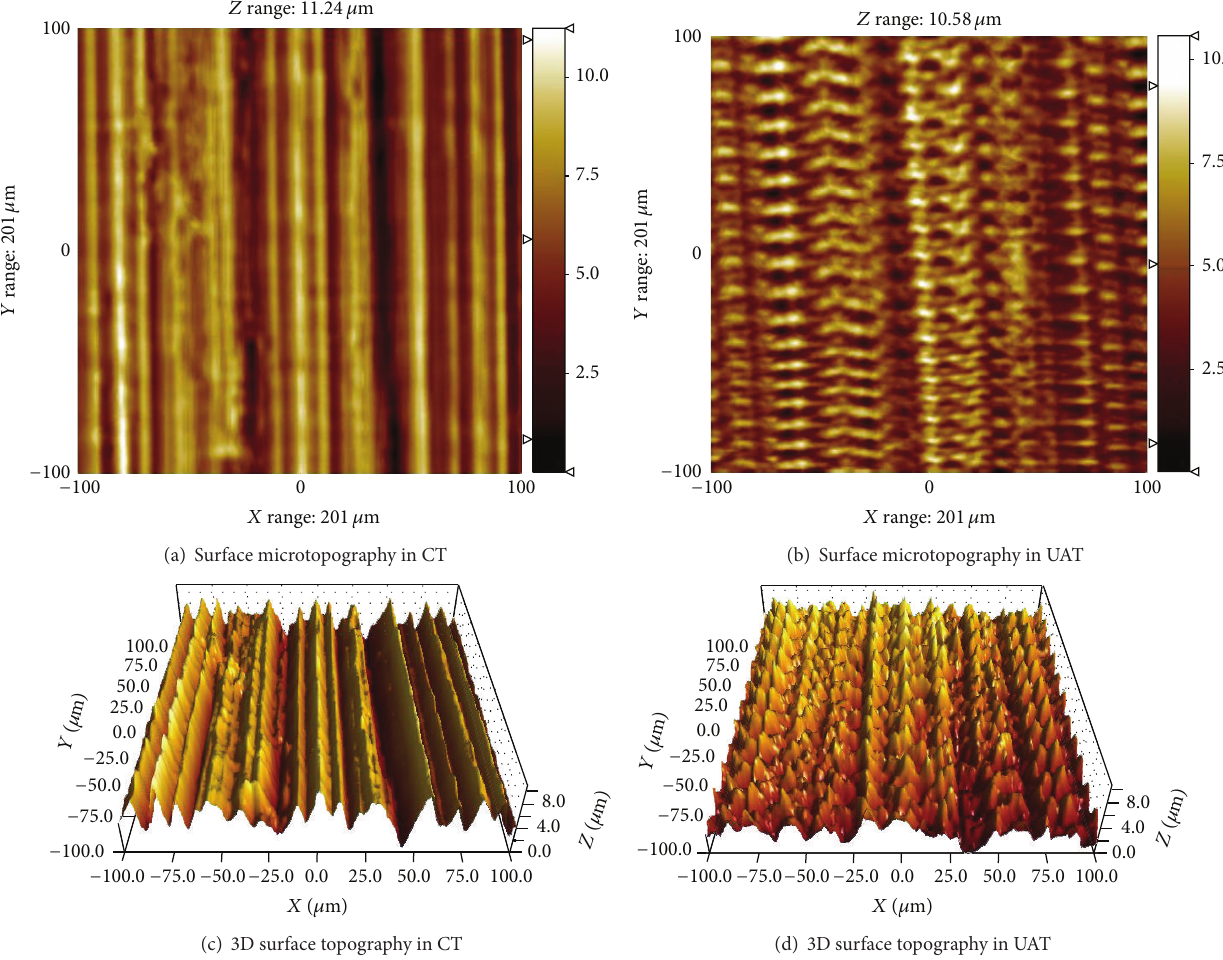
Figure 13: Surface microtopography and 3D surface topography in UAT and